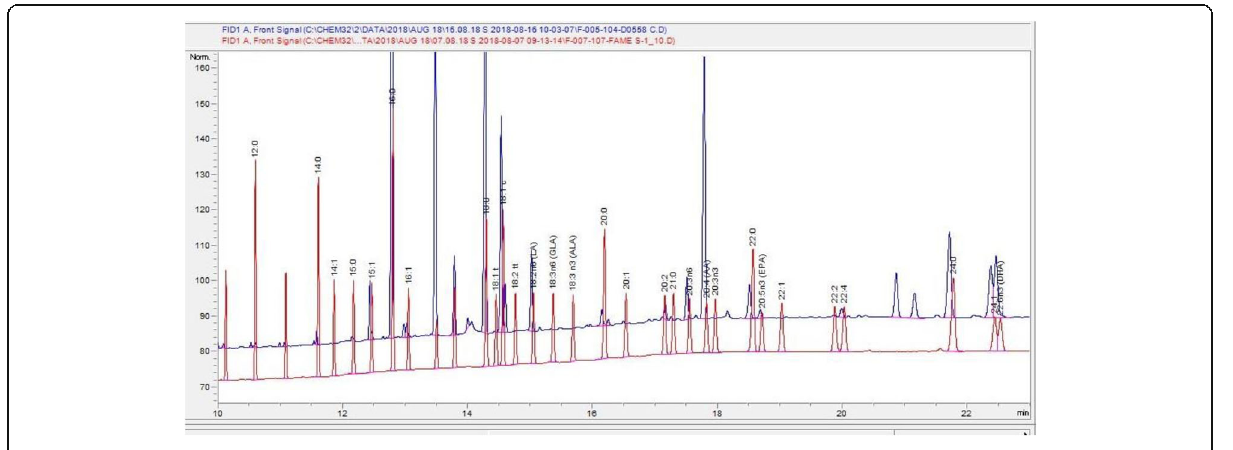
Fig. 1 Overlay of FAME mix (red) with an RBC pool (blue)